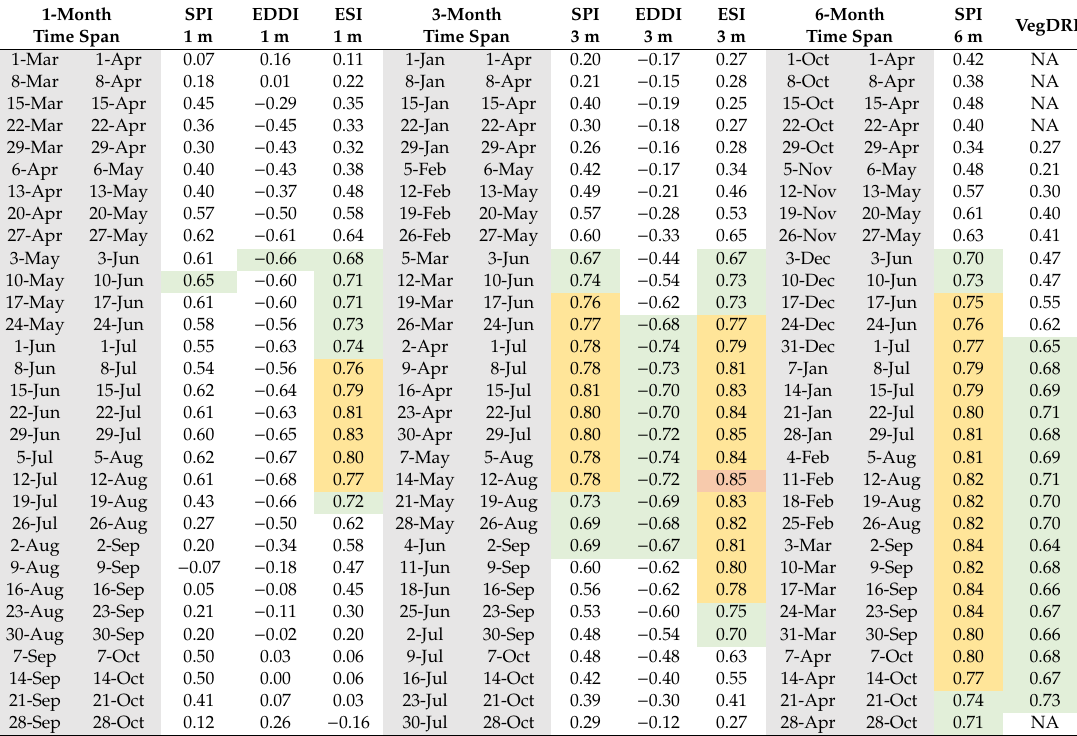
Table 3. Summary of the R values for each drought index used in the regression analysis and the time period that each index represents. Di ff erent numbers of points and years were evaluated by various indices: SPI and EDDI (n = 1700, 2000–2016), ESI (n = 1696, 2001–2016), VegDRI (n = 800, 2009–2016). Points that did not have an assigned value were excluded from the analysis. Five weeks (first four weeks and the last week) of the growing season for VegDRI analysis were not evaluated due to the lack of data (“out of season” according to the VegDRI methodology). Correlation coe ffi cient values that are equal to or higher than 0.65 are indicated in green, higher than 0.75 in yellow, and the highest correlation (0.85) in